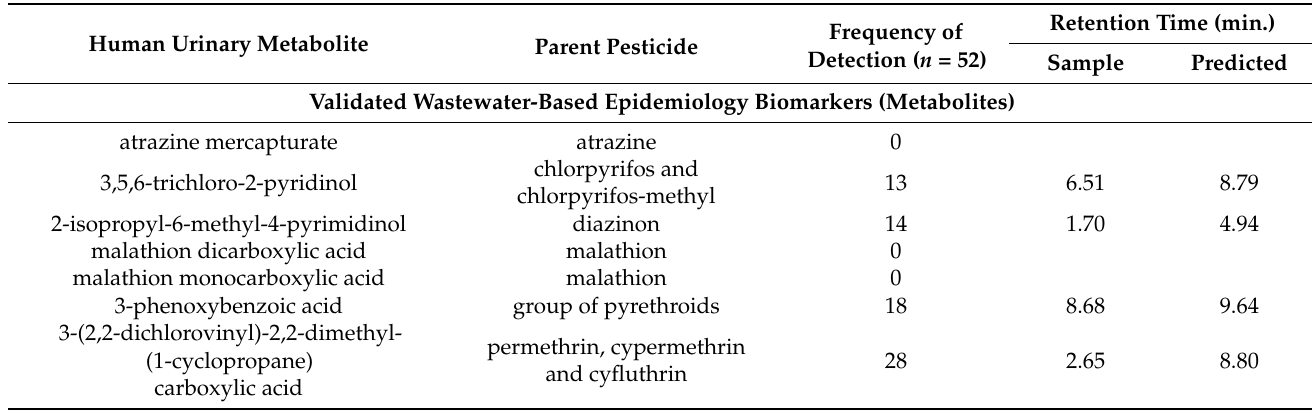
Table 1. Suspect analysis of human urinary metabolites in influent wastewater sampled in Athens between 2014 and 2020. Human Urinary Metabolite Parent Pesticide